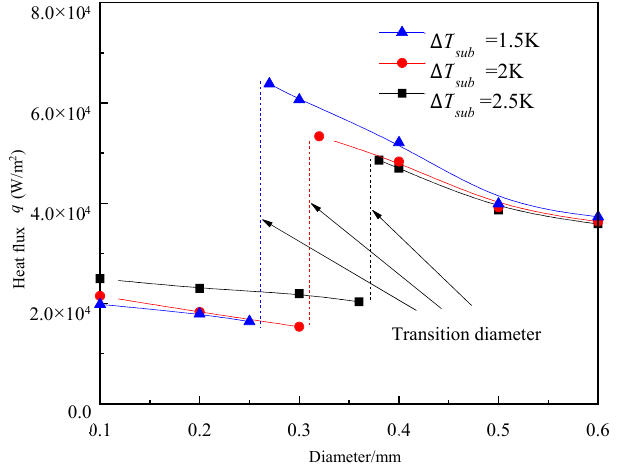
Figure 17. Bubble departure diameter for 0.5 mm wire heaters with different subcooling degrees.